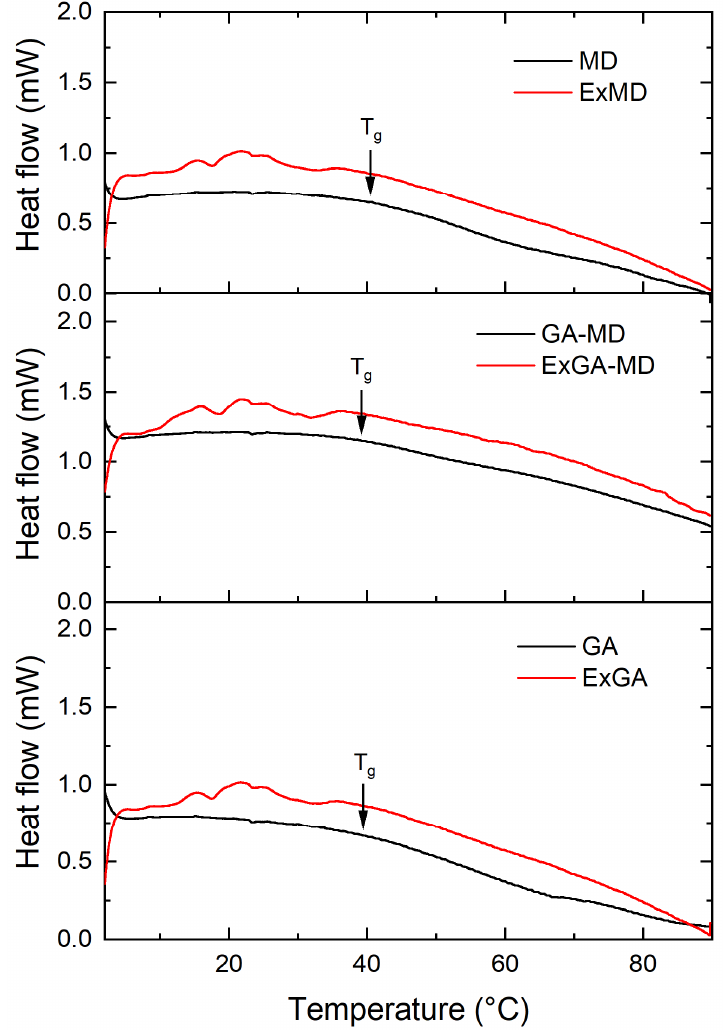
Figure 2. Thermograms of microencapsulated hop extract made of different carriers (red lines) and their references (without extract) (black lines) equilibrated at a w 0.55.